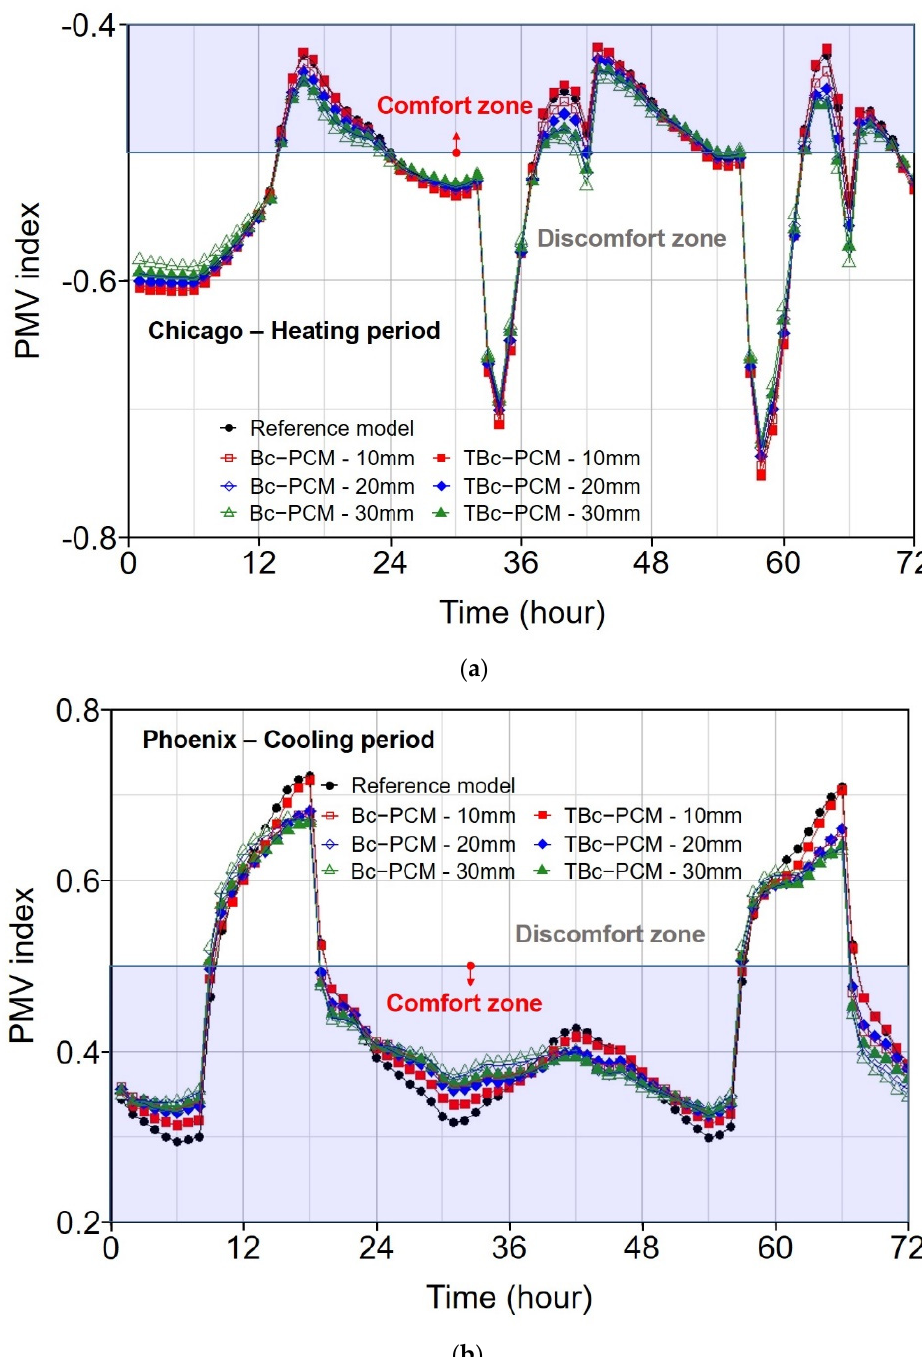
Figure 8. PMV index changes in ( a ) Chicago during heating period and ( b ) Phoenix during cooling period.